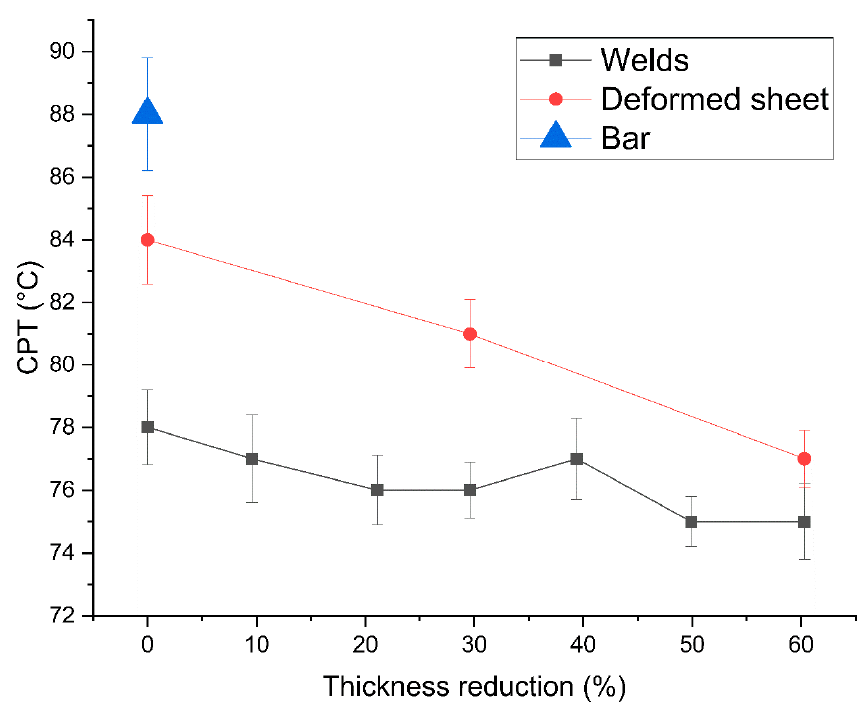
Figure 10. CPT trend of welded and unwelded sheets. For comparison is also reported the CPT of a bar of UNS S32750.